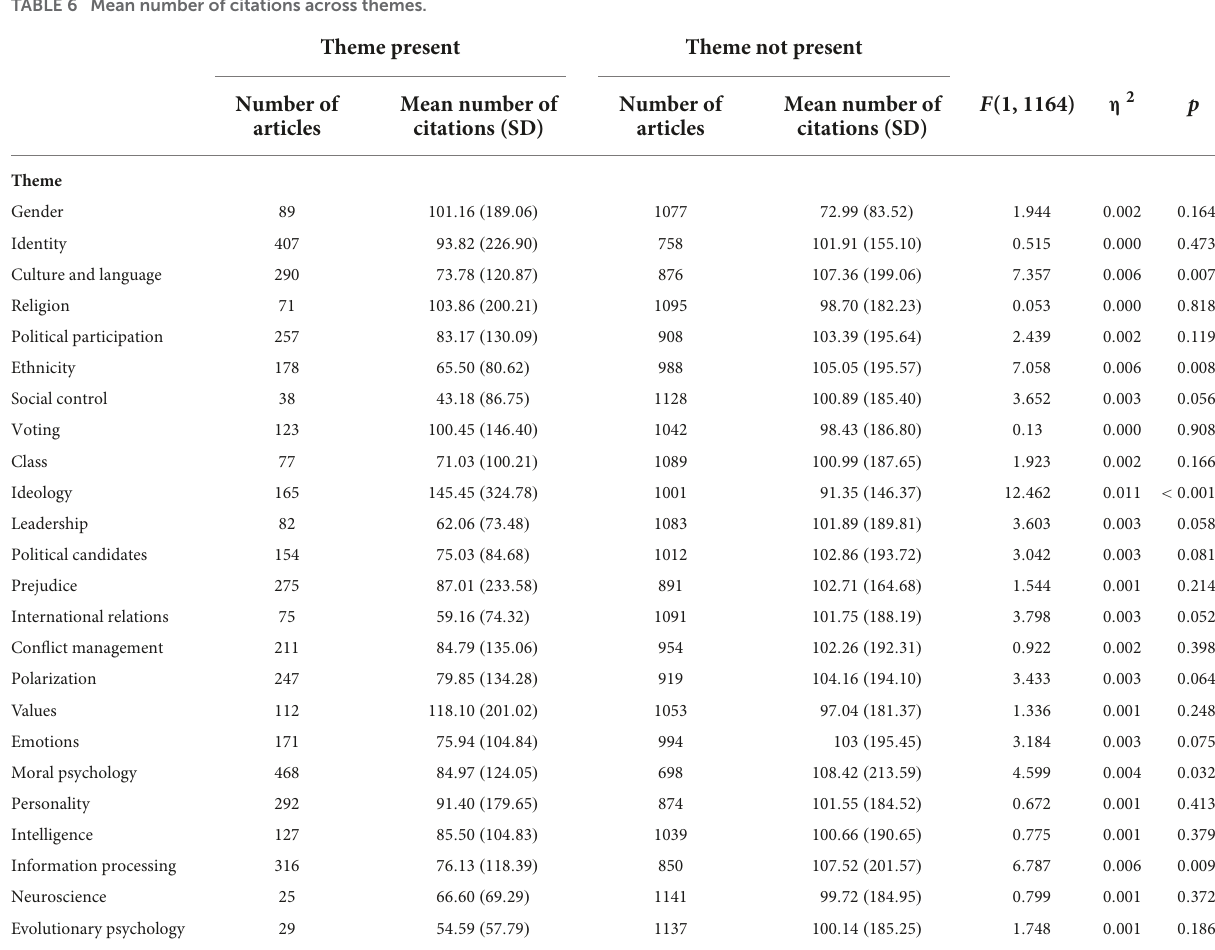
TABLE 6 Mean number of citations across